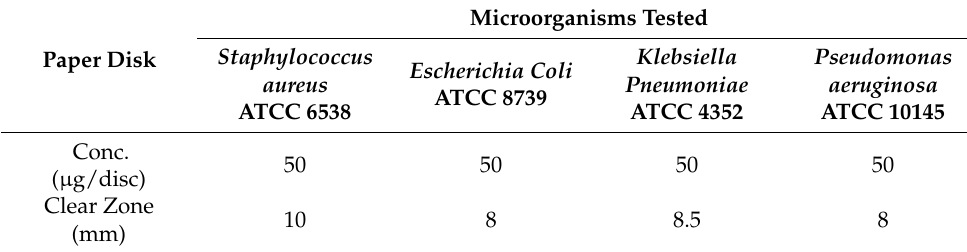
Table 6. Antimicrobial activities of 5% olive leaves (OLs) fractions.